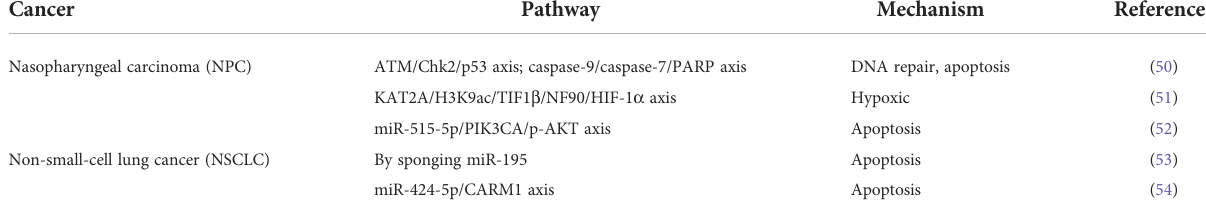
TABLE 2 Molecular mechanisms underlying PVT1-induced